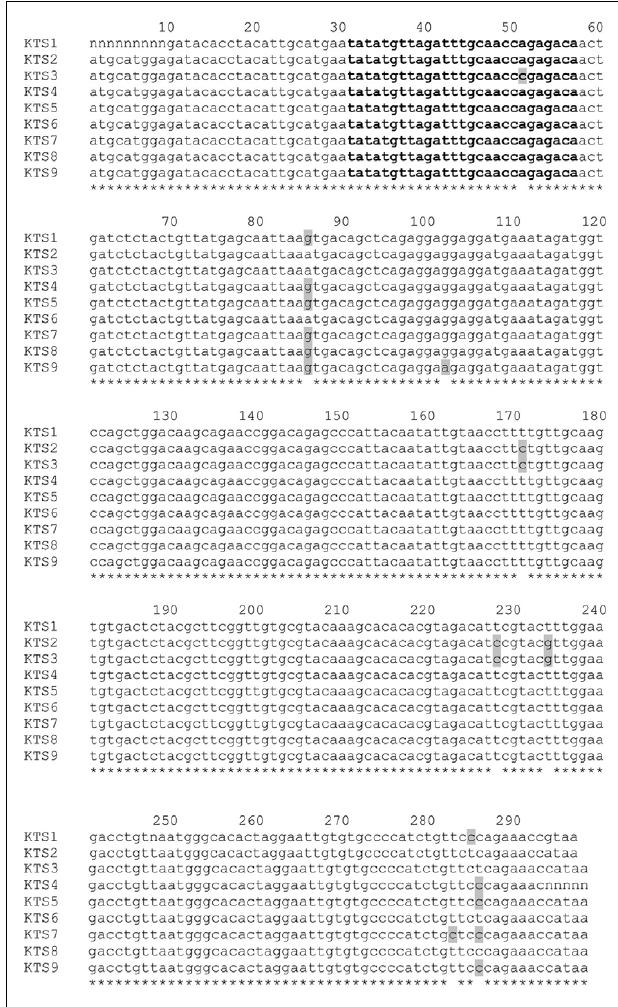
FIGUREA2 | Multiple alignment of Raw E7 DNA sequences. Multiple sequence alignments of HPV E7 sequences from tumor biopsies KTS1–9 are shown.The reference sequence is E7 from KTS6, identical to worldwide strain that has 100% identity to more than 50 reported sequences (representative sequence: GenBank K02718; Seedorf et al., 1985). E7 KTS1 is a novel sequence showing a single nt difference to East Asian (AF534061) andThai (FJ610150) strains. KTS2 represents another worldwide strain (AY686582). E7 KTS3 is a novel sequence showing a single nt difference to the worldwide strain (AY686582). E7 KTS4, KTS5, and KTS8 sequences represent Asian strains (AF534061). E7 KTS7 sequence represents East Asian strain (AF486333). E7 KTS9 sequence represents East Asian strain (AF486332). Positions 31–57 encode HLA-A02 T cell epitopeYMLDLQPET. Codon 85–87 encodes amino acid variability (N or S), while all other variable positions, shown as shaded, represent silent mutations. Unresolved nucleotides in KTS1 and KTS4 are represented by ambiguity code “ n ”. In summary, the HPV E7 sequence variability in the cohort is relatively high, representing multiple HPV-16 species. At the protein level, on the contrary, the sequence is extremely well conserved indicating high stability of the protein product.